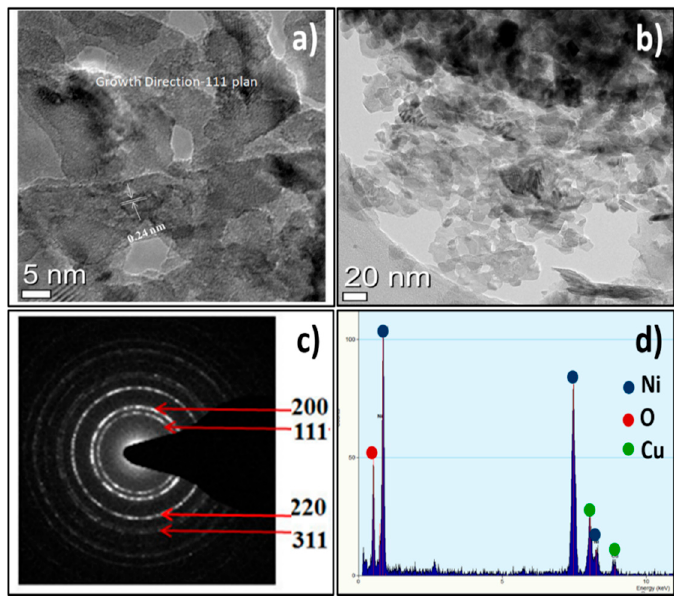
Figure 2. ( a , b ) HR-TEM, ( c ) SAED, and ( d ) EDX of NiO NPs.